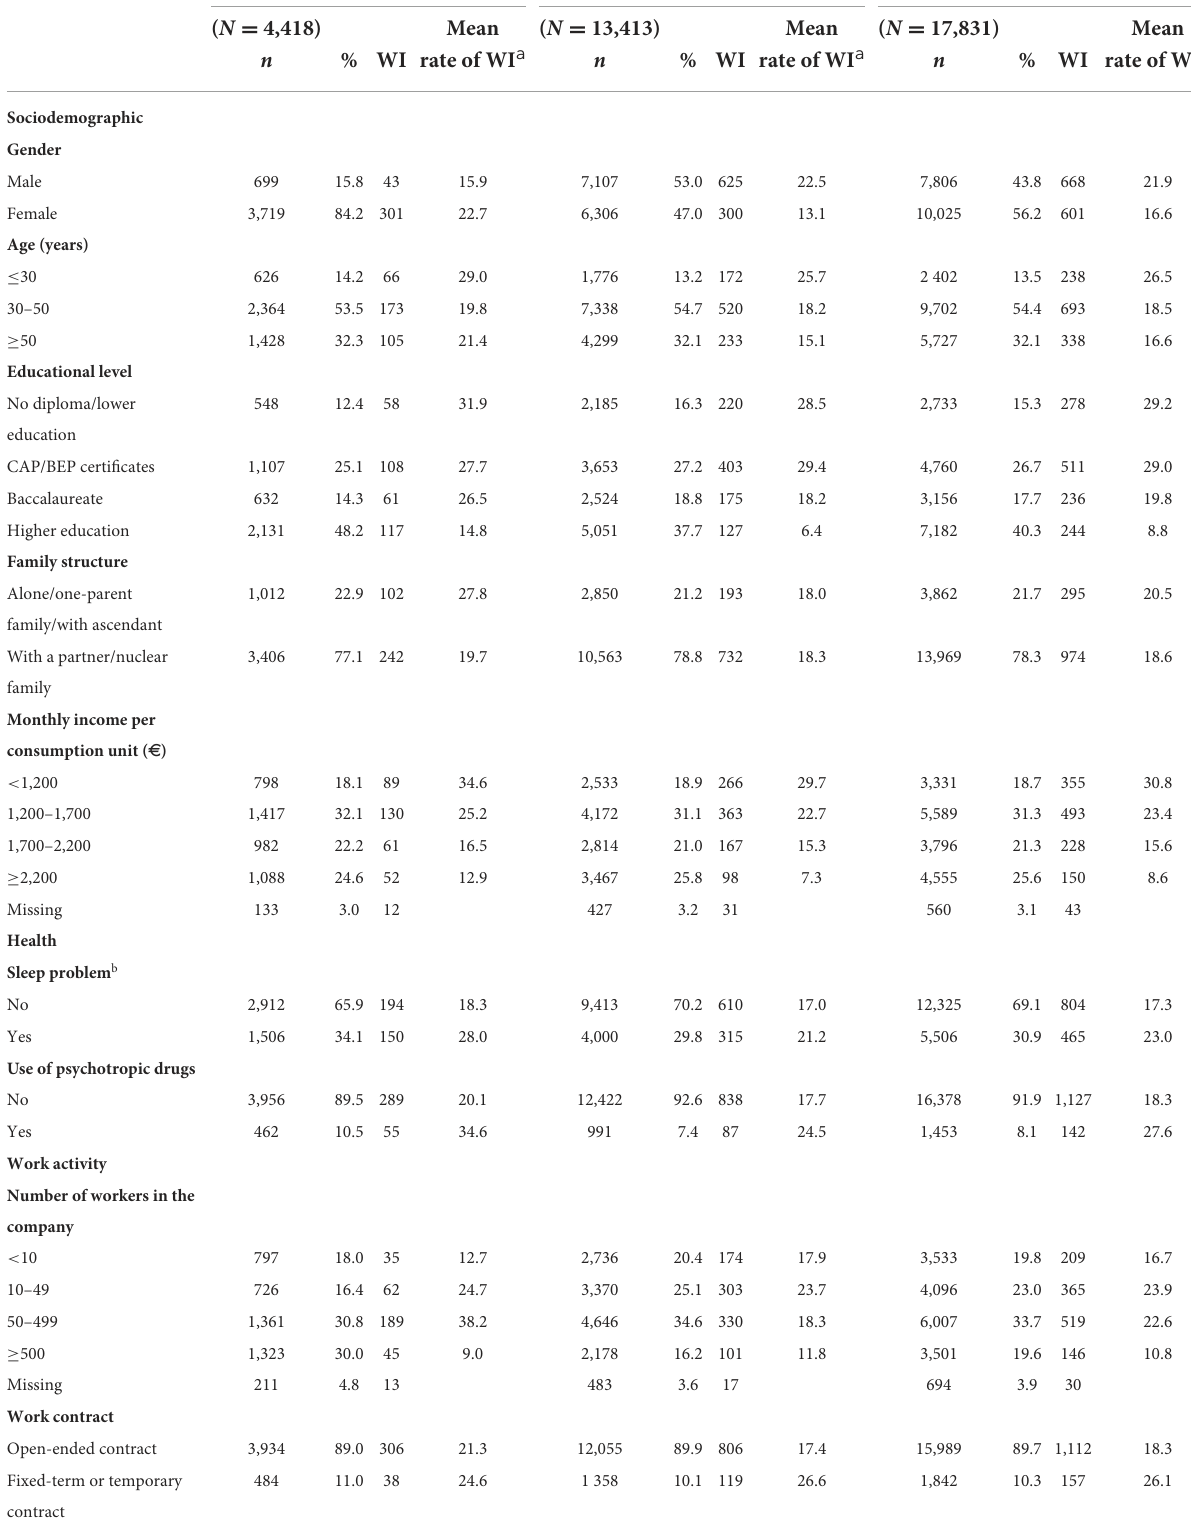
TABLE 1 Characteristics of participants at inclusion in 2013 and mean rate of workplace injuries (WI). Care workers Other workers All workers ( N = 4,418) Mean ( N = 13,413) Mean ( N = 17,831) Mean n % WI rate of WI a n % WI rate of WI a n % WI rate of WI